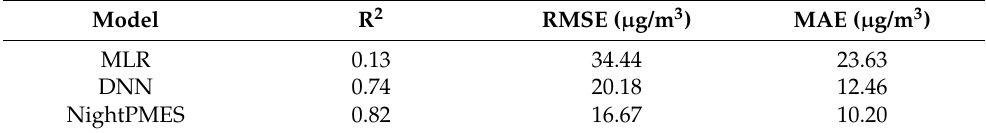
Table 5. Comparison of various estimation models of PM 2.5 concentration in the BTH region at night. Model R 2 RMSE ( µ g/m 3 ) MAE ( µ g/m 3 )